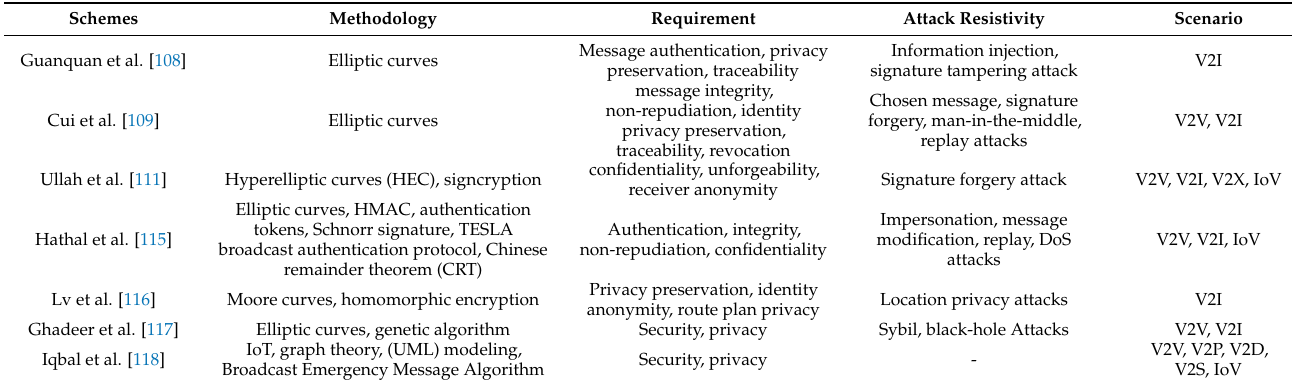
Table 13. Classification of other authentication